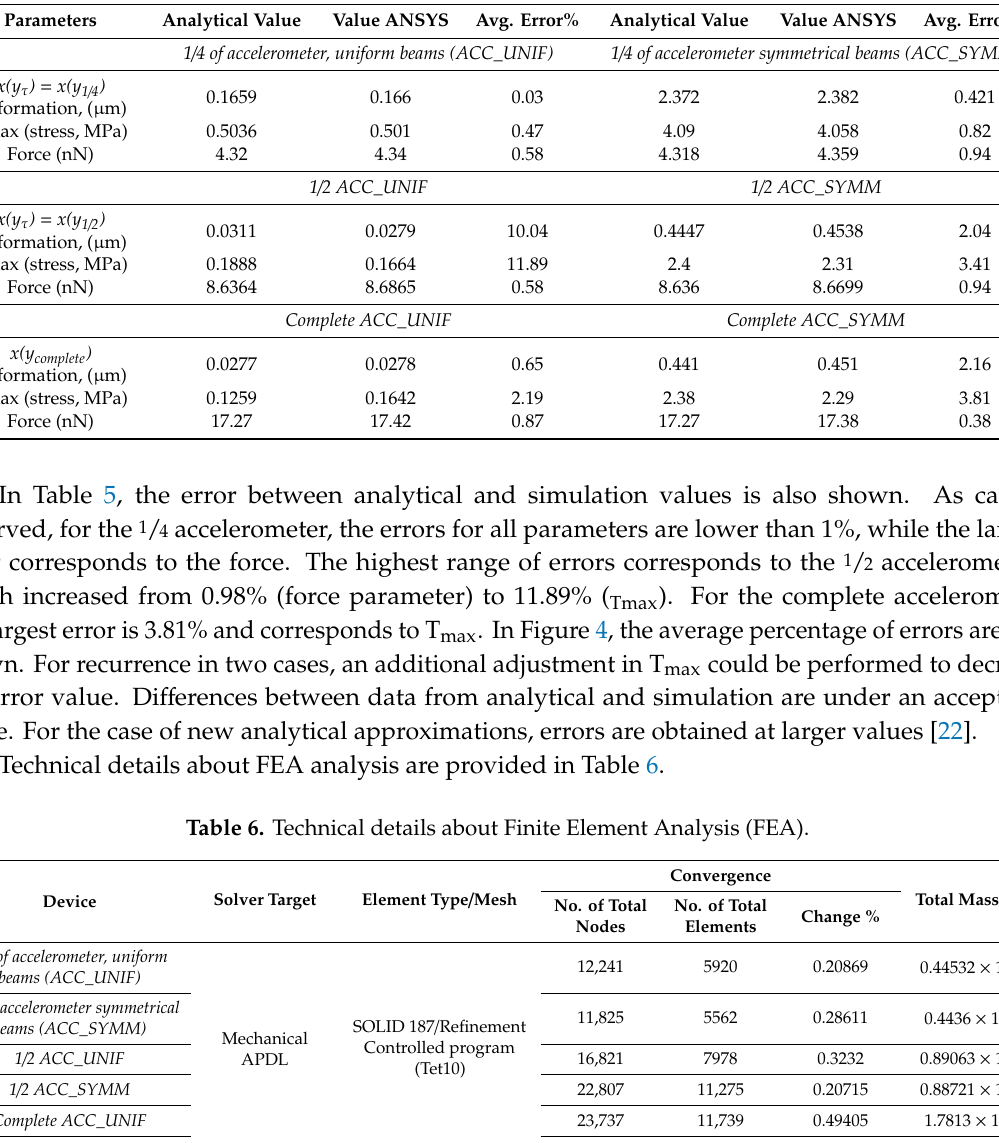
Table 5. Parameters of the 1 / 4 accelerometer with uniform and symmetrical beams at 1 g.